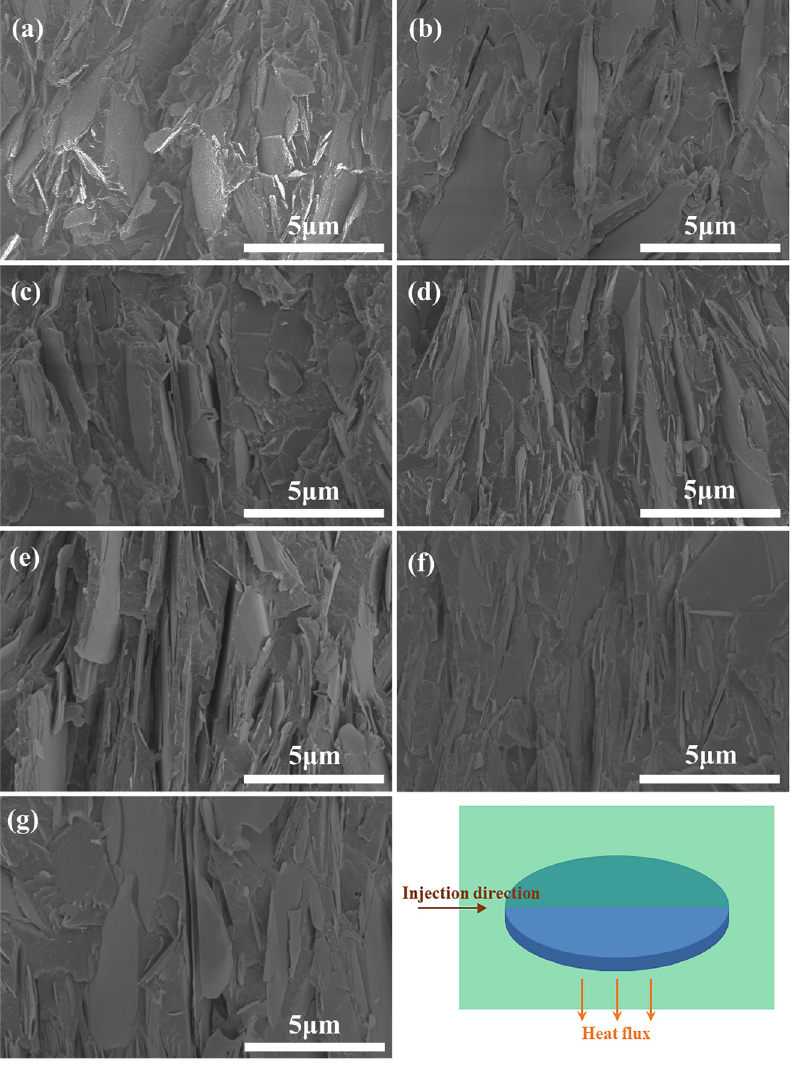
Figure 1. FESEM graphs of composites of ( a ) PA6/BN, ( b ) PA6/BN/SA1, ( c ) PA6/BN/SA2, ( d ) PA6/BN/SA3, ( e ) PA6/BN/SA4, ( f ) PA6/BN/SA5, and ( g )